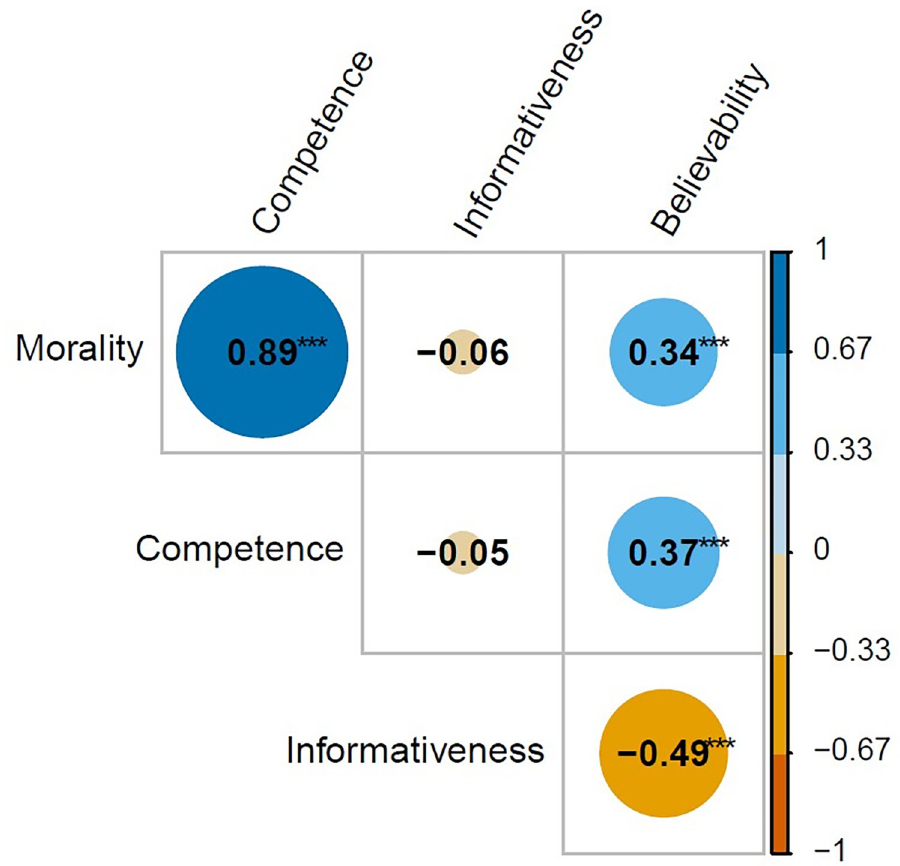
Fig 2. Correlations between the morality, competence, informativeness, and believability ratings. The color shows the direction of the relationship, with positive in blue and negative in orange. Circle size shows the strength of the relationship, with a larger circle indicating a stronger relationship. Note � p < .050, �� p < .010, ��� p < .001.